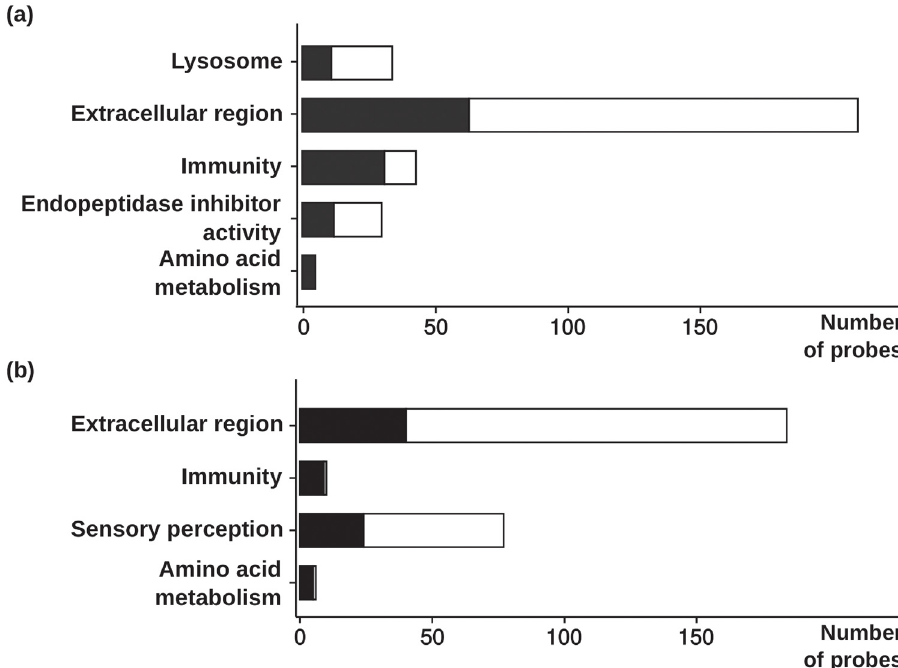
Fig 3. Gene ontology enrichment analysis results. Cluster with number of genes up (in black) and down-regulated (in white), issued from the gene ontology enrichment analysis using DAVID bioinformatics resource for the (a) R23h versus AB1h and (b) R23h versus A22h comparisons (Cut-off: p-value < 0.01; Benjamini < 0.1).